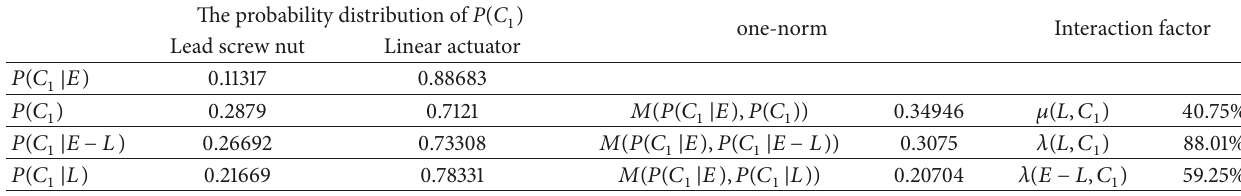
Figure 12: Three methods result. Table 9: Interaction factor of L on P ( C 1 ).